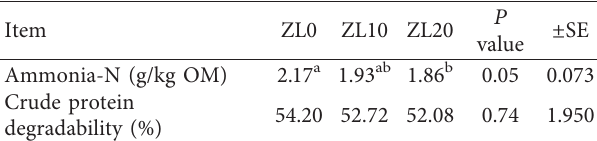
Table 2: Effect of ZL supplement on ammonia-N and crude protein degradability of the testing diet incubated in digestive tract content.